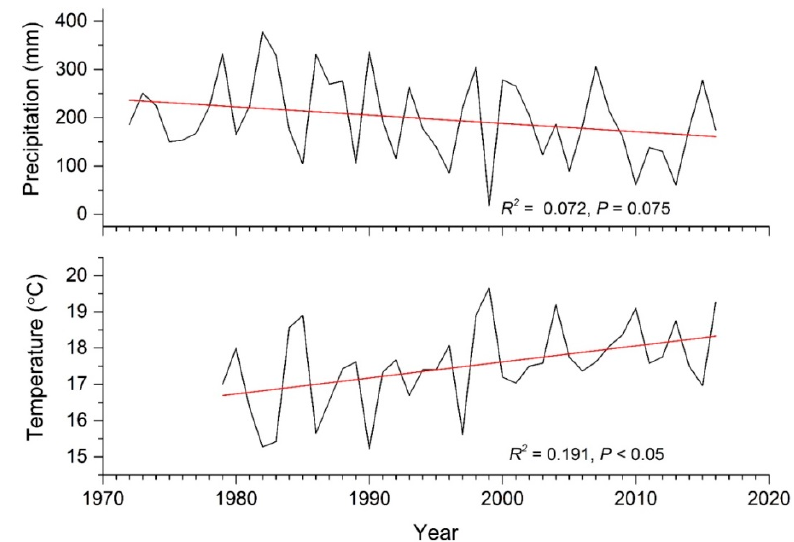
Figure 3. Time series of spring (March to May) precipitation (1972–2016) and temperature (1978–2016) from the Dadeldhura meteorological station. Spring temperature showed a significantly increasing trend, and spring precipitation showed a decreasing trend, but not significant.